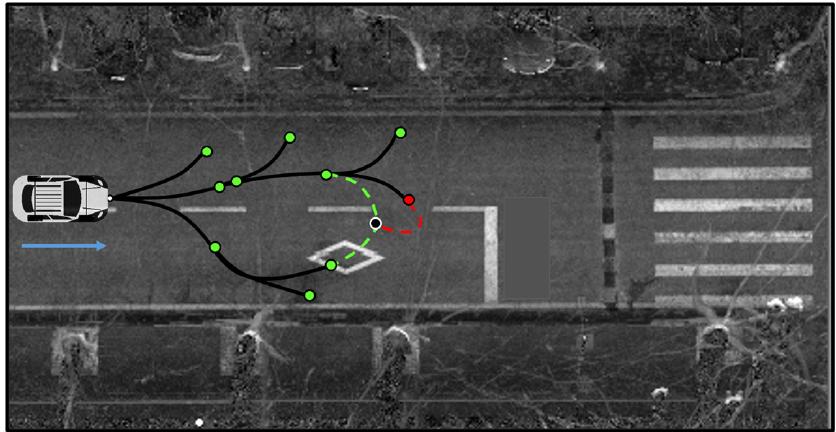
Figure 11. Detour constraint.